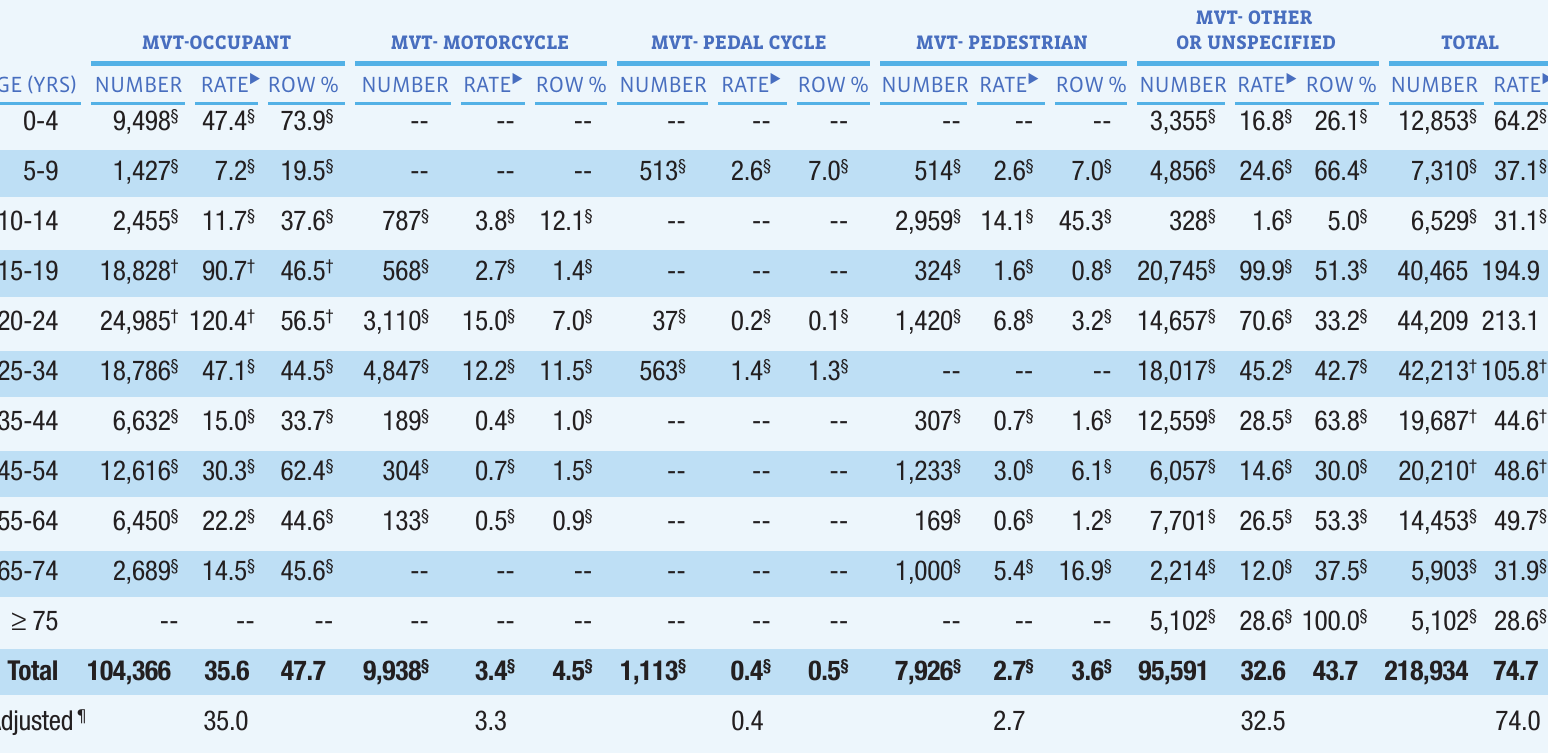
TABLE 6: Estimated Average Annual Numbers, Rates, and Percentages of Traumatic Brain Injury-Related Emergency Department Visits, by Age Group and Specific Motor Vehicle–Traffic (MVT) External Causes, United States,